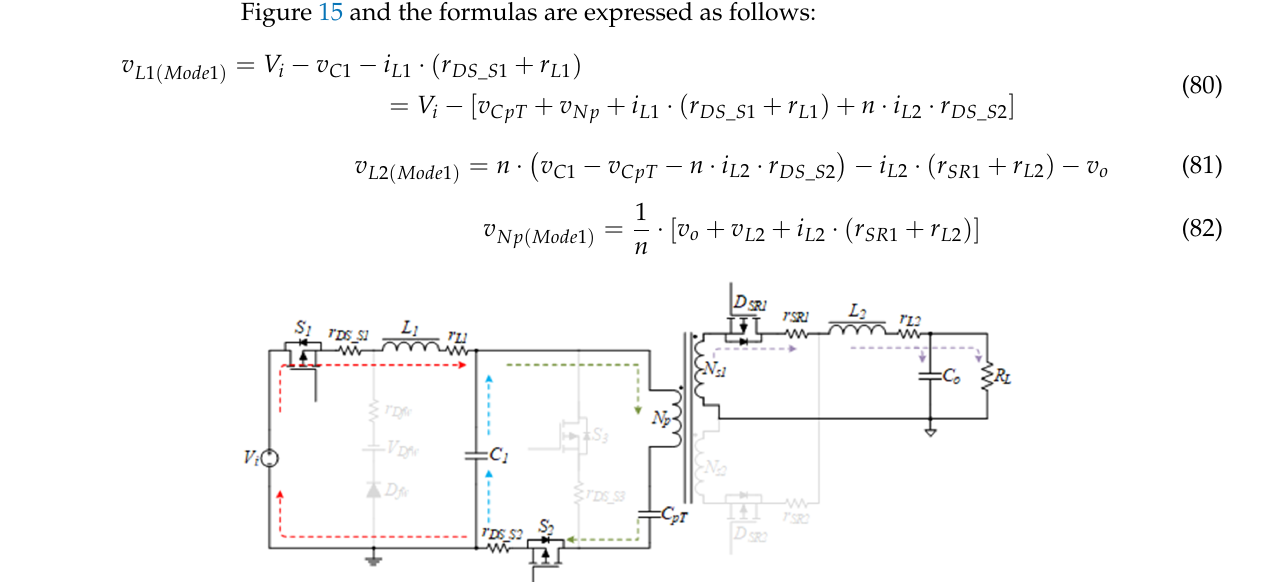
Figure 14. Equivalent circuit with parasitic components of the proposed topology.